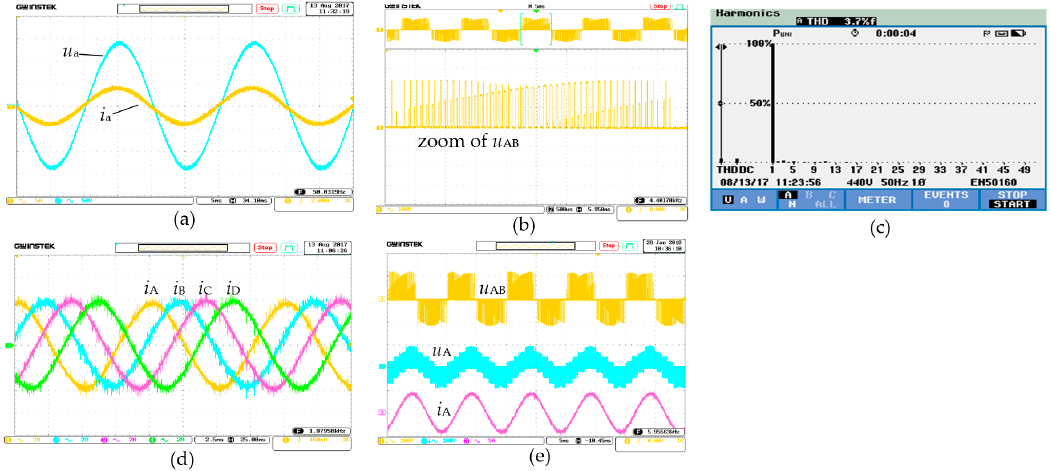
Figure 9. Experimental waveforms with U in = 100 Vrms, f out = 100 Hz, and q = 0.6: ( a ) input voltage u a and input current i a ; ( b ) output line ‐ to ‐ line voltage u AB and zoom of u AB ; ( c ) the FFT analysis of the u AB ; ( d ) output currents i A , i B , i C , i D ; ( e ) output line ‐ to ‐ line voltage u AB , output phase voltage u A , and output phase current i A .